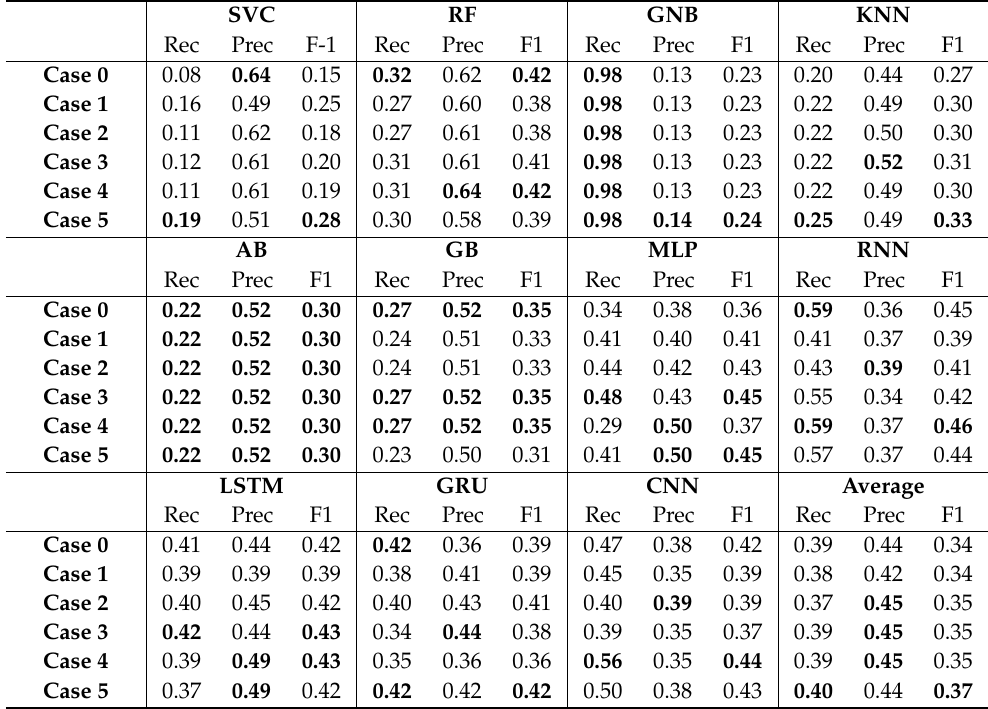
Table A6. Test results for induced/evolved rules used as an additional predictive feature, considering a time prediction horizon of +10